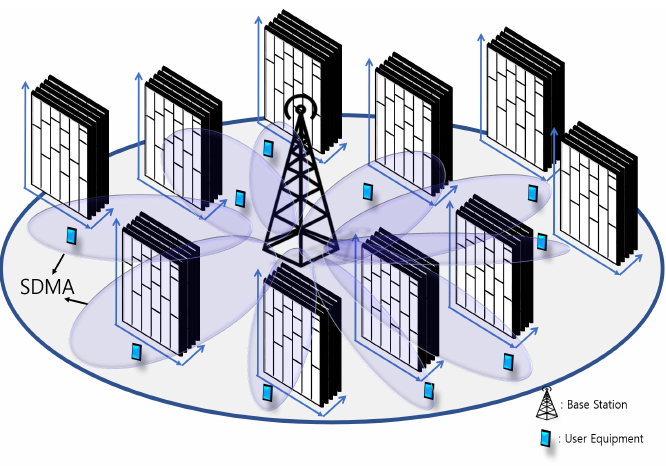
Figure 3. The downlink single-cell MU-MIMO